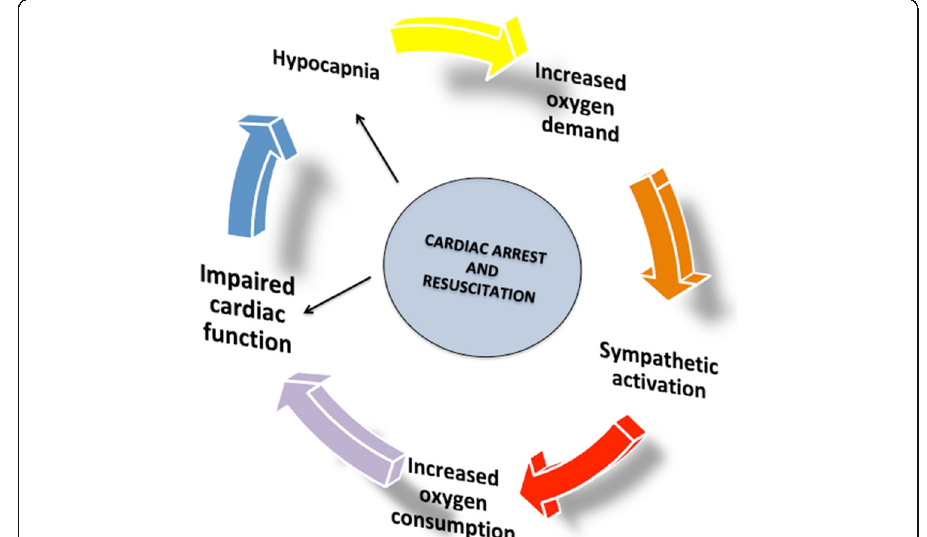
Fig. 4 The pathophysiologic vicious circle after cardiac arrest: hyperventilation and hypocapnia can quickly cause intracellular and extracellular pH increase; this increases metabolic energy and O 2 demand, while ATP production is reduced in cardiac arrest for the activation of the anaerobic pathway; this determinates a sympathetic-like activation aimed to compensate the increased energy demand. Also, cardiac arrest per se' and pH derangements strongly influence intracellular function, thus increasing metabolic expenditure, and oxygen consumption. This occurs in the contest of cardiac injury related to the cardiac arrest as well as to pH changes which can further impair cardiac function; impaired myocardium function results in impaired diastolic function with further hyperventilation and hypocapnia. O 2 , oxygen; ATP, adenosine